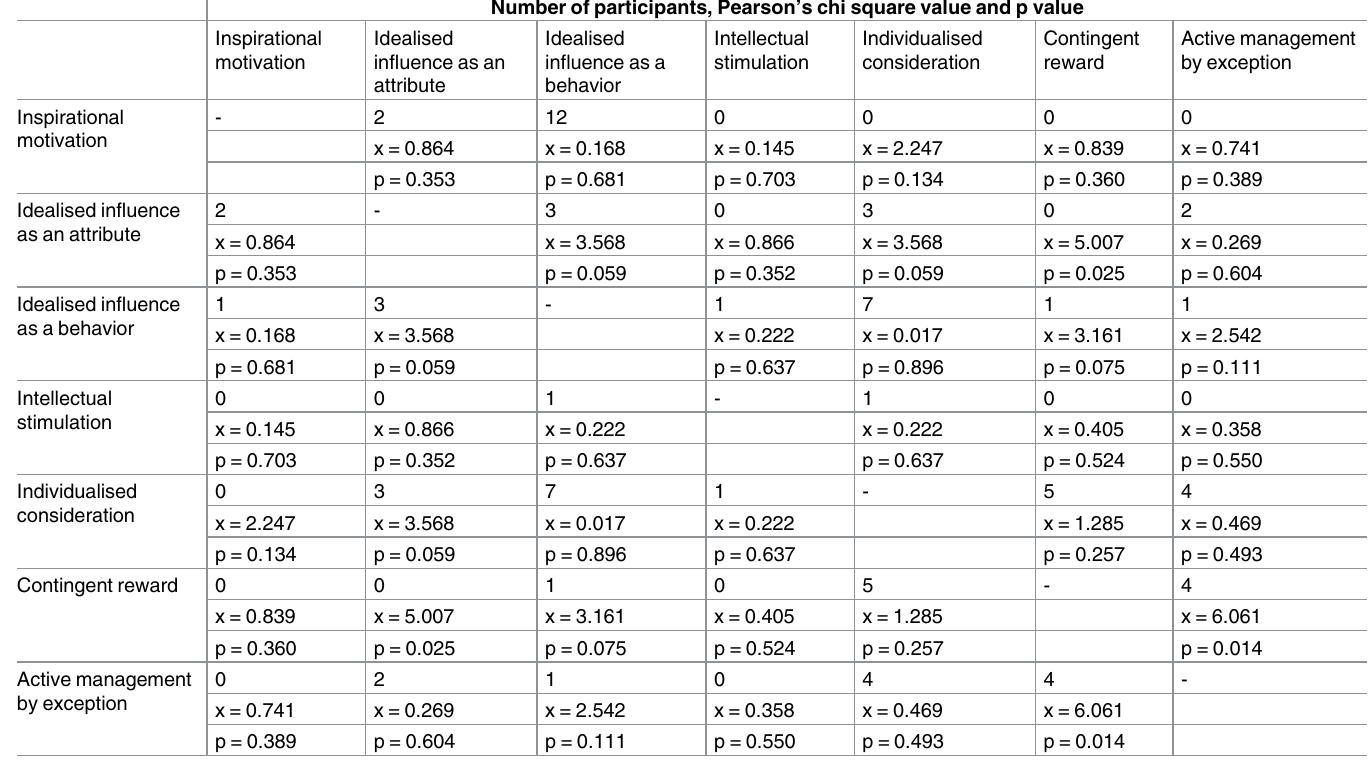
Table 5. Pairs of factors identified by participants when describing their own leadership